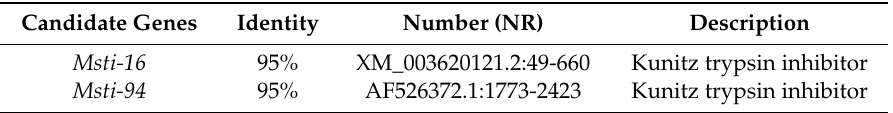
Table 6. Sequence homology of the selected candidate genes ( Msti-16 and Msti-94 ) obtained from the National Center for Biotechnology Information